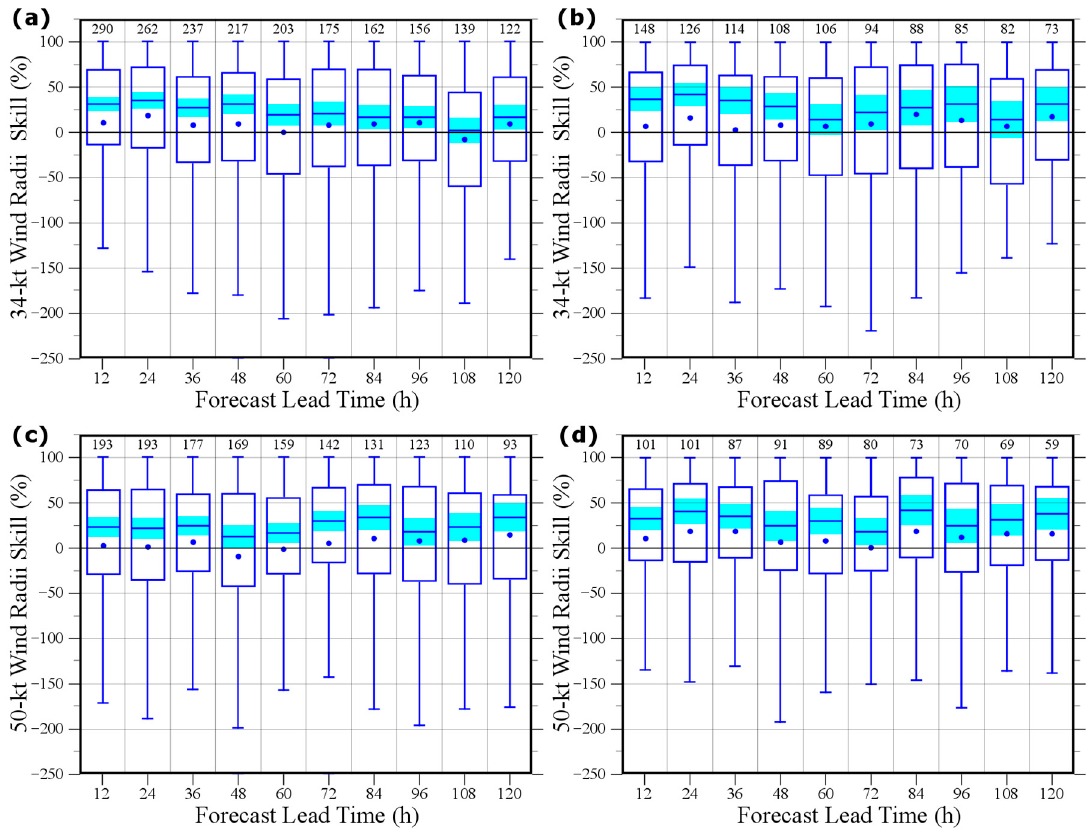
Figure 4. As in Figure 2, except in the North Atlantic for: ( a , b ) the radius of 34 kt (gale) winds and ( c , d ) the radius of 50 kt (storm) winds. In ( a , c ), the full sample is used. In ( b , d ) only forecasts with two or three storms at the model initialization time were included. The number of cases is printed at the top of each column.